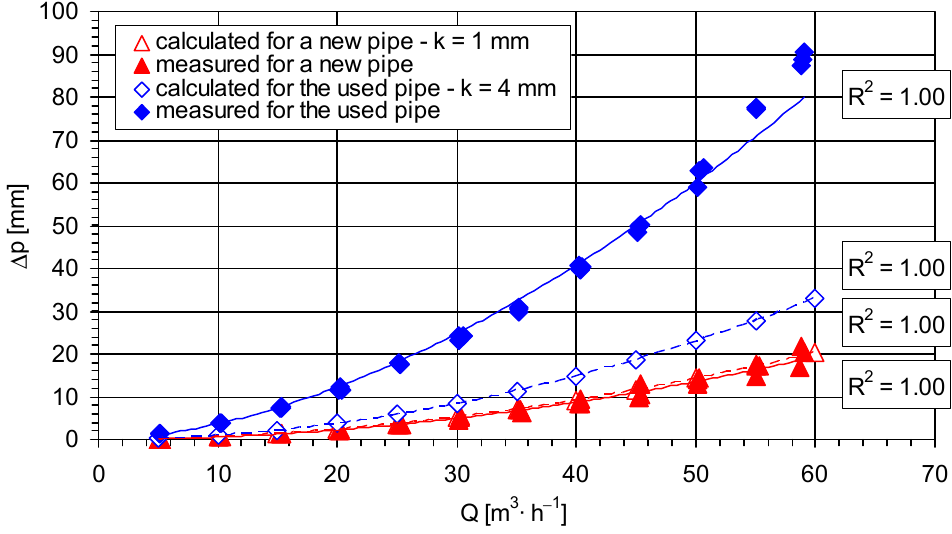
Figure 10. Average values of real pressure difference ∆ p calculated for the cast-iron pipes with the internal diameter d = 150 mm according to the standard [49] and measured for the new pipe and for the pipes after 30-year exploitation.